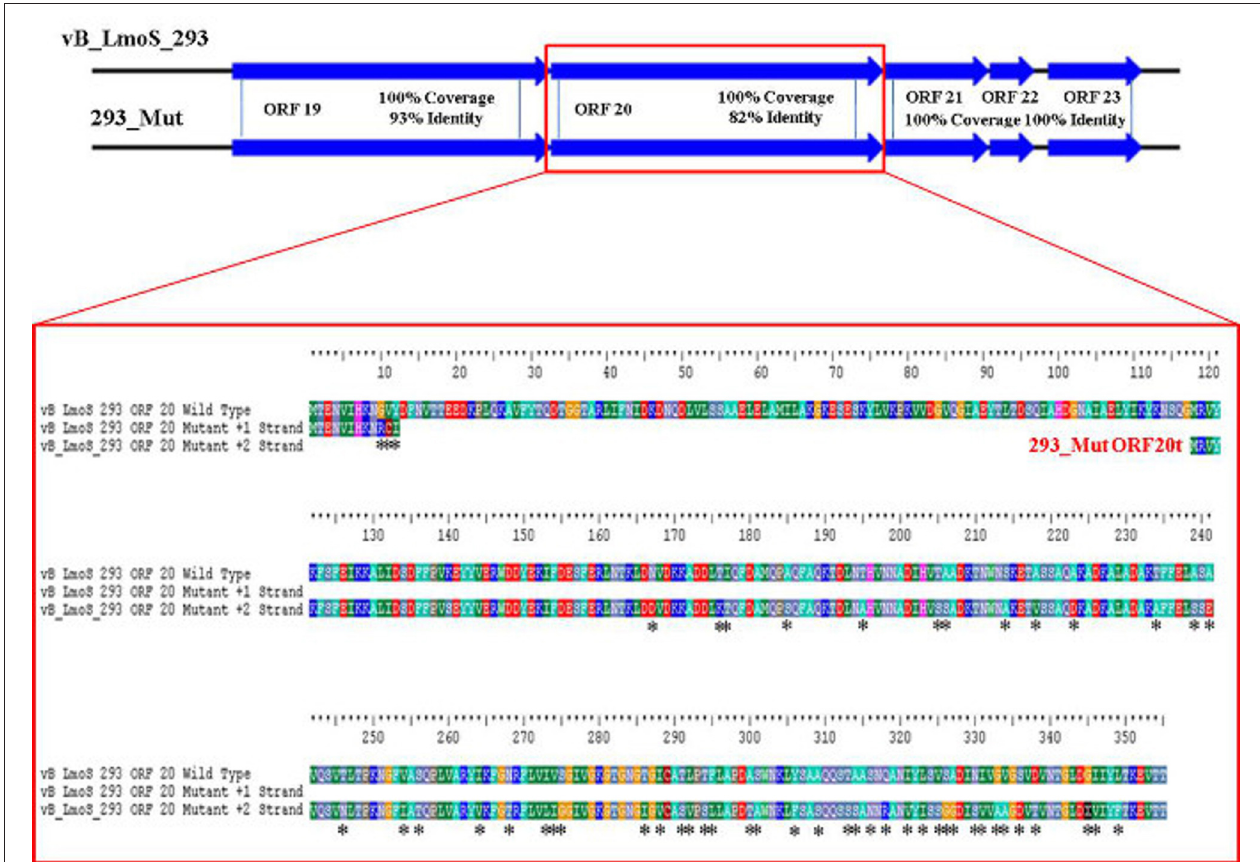
FIGURE 7 | Amino acid sequence alignment of open reading frame (ORF) 20 of phage vB_LmoS_293 and its corresponding ORF in phage 293_Mut. Alterations in amino acid sequence in the mutant ORF compared to the wild-type are denoted with